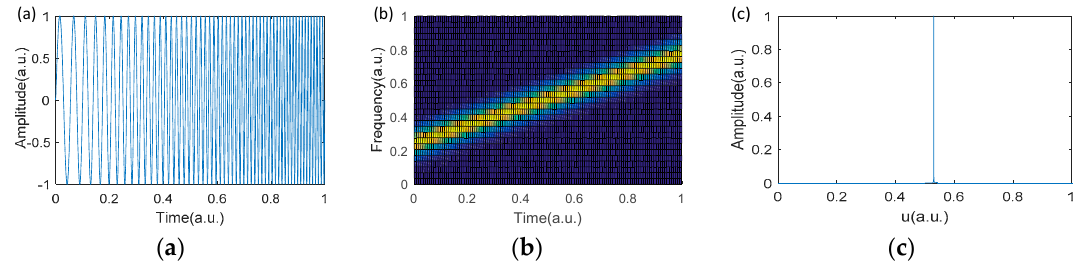
Figure 2. T-section of an LFM signal (time normalizes with respect to T). ( a ) Time-domain waveform and ( b ) time–frequency distribution; ( c ) fractional Fourier transform when the FM slope of the decomposition basis is equal to that of the LFM signal.